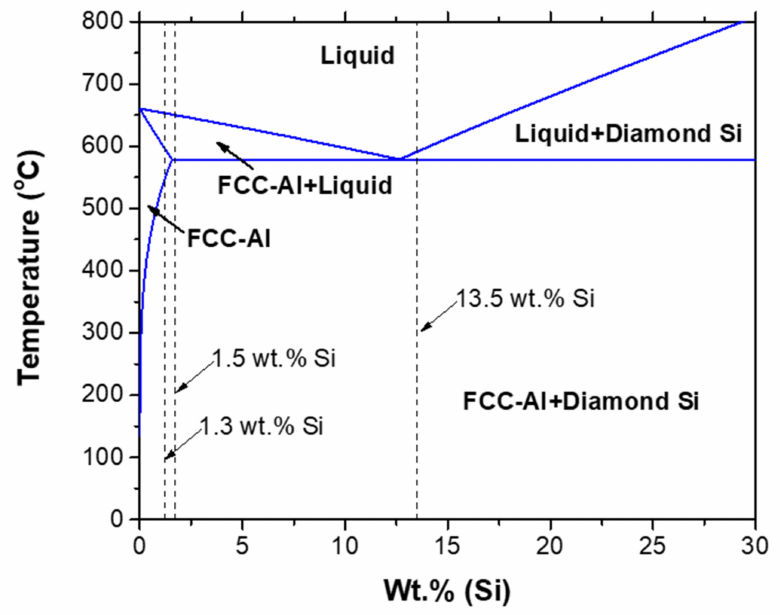
Figure 1. The calculated Al–Si partial phase diagram near the Al-rich terminal